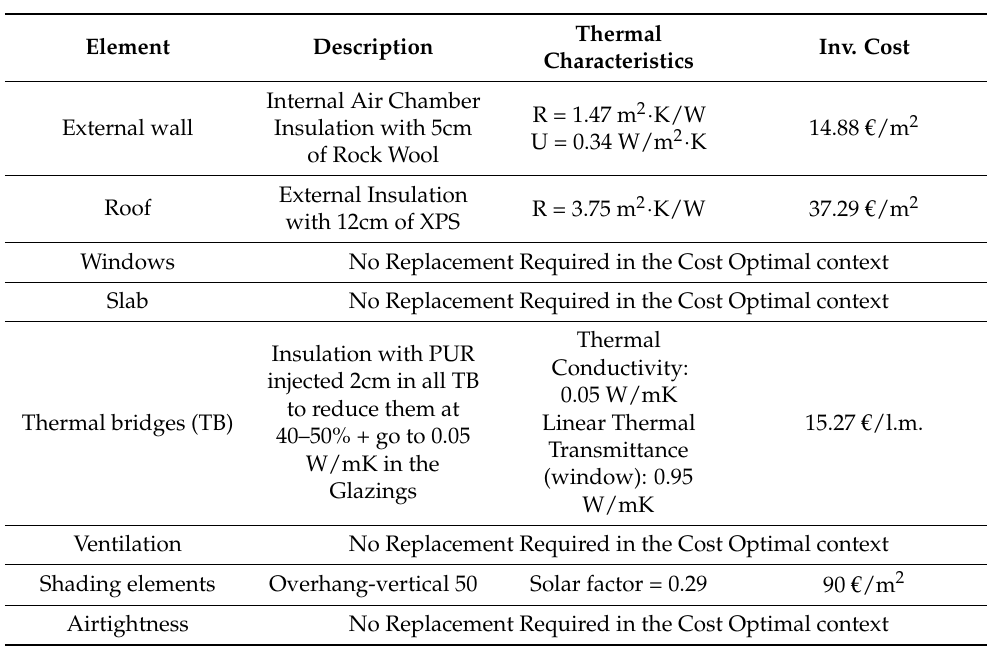
Table 9. POS1: Renovation measures of solution